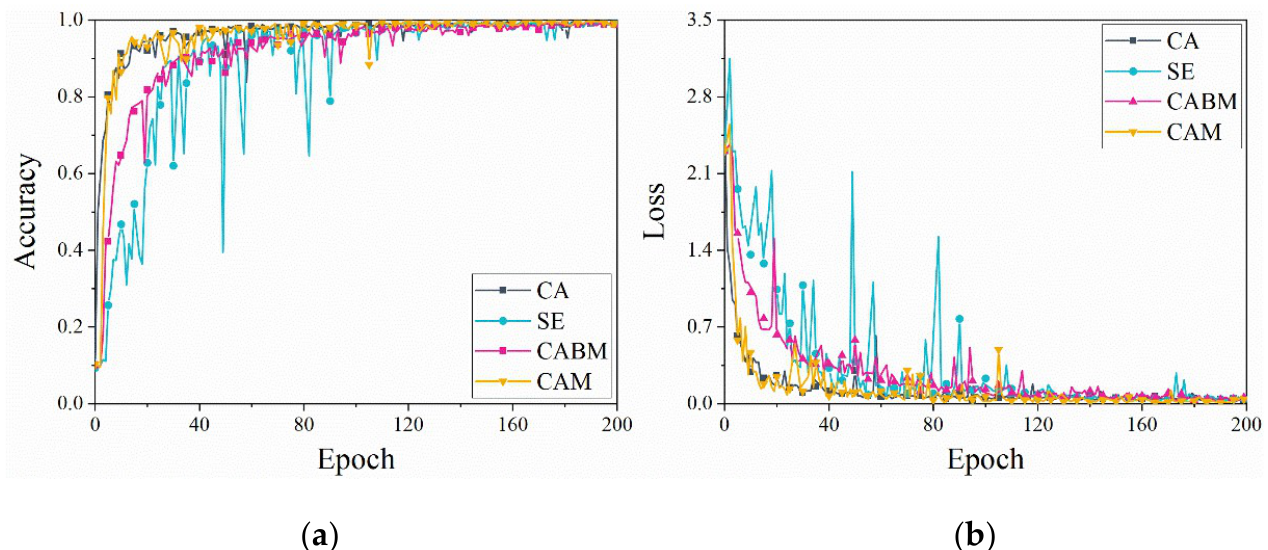
Figure 8. Present the training process of the model with different attention modules. ( a ) Loss, ( b ) Accuracy.